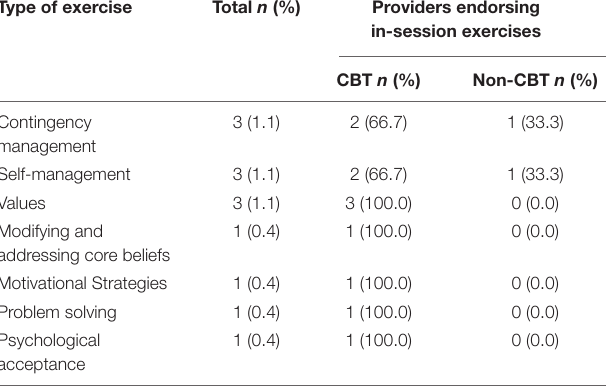
TABLE 2 | Conducting in-session exercises with telemental health